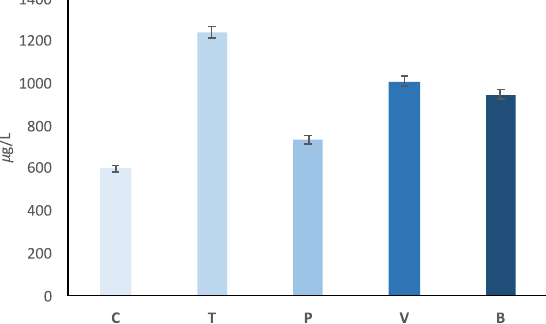
Figure 1. Sums of concentrations (µg/L) of 129 volatile mass peaks in the head spaces of cooked meat samples; results are given with standard error. The 2 avian breast meats (chicken—C and turkey—T) are not significantly different from the 3 mammalian loin meats (pork—P, veal—V and beef—B); chicken meat had a lower ( P < 0.001) concentration than turkey meat; pork had a lower ( P < 0.001) concentration than bovine (veal and beef) meats; veal and beef meats were not significantly different (RMSE: 183 µg/L).